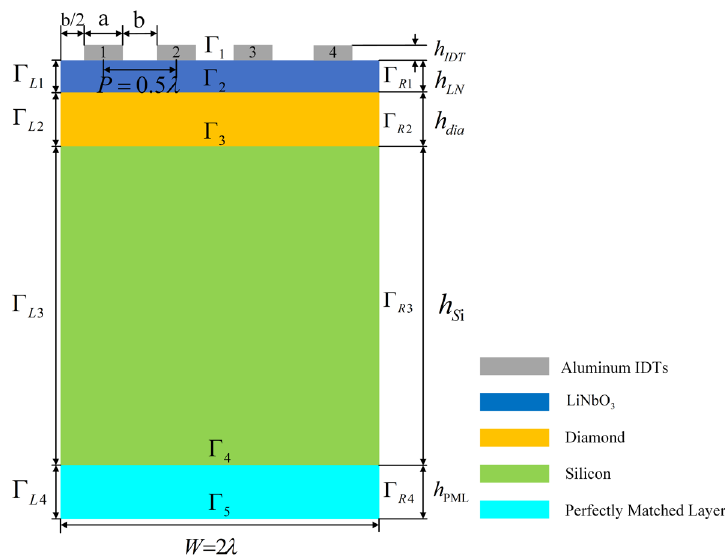
Figure 3. Two-dimensional simulation model of SAW resonator with layered structure. Table 1. Non piezoelectric material parameters used in the simulation model.